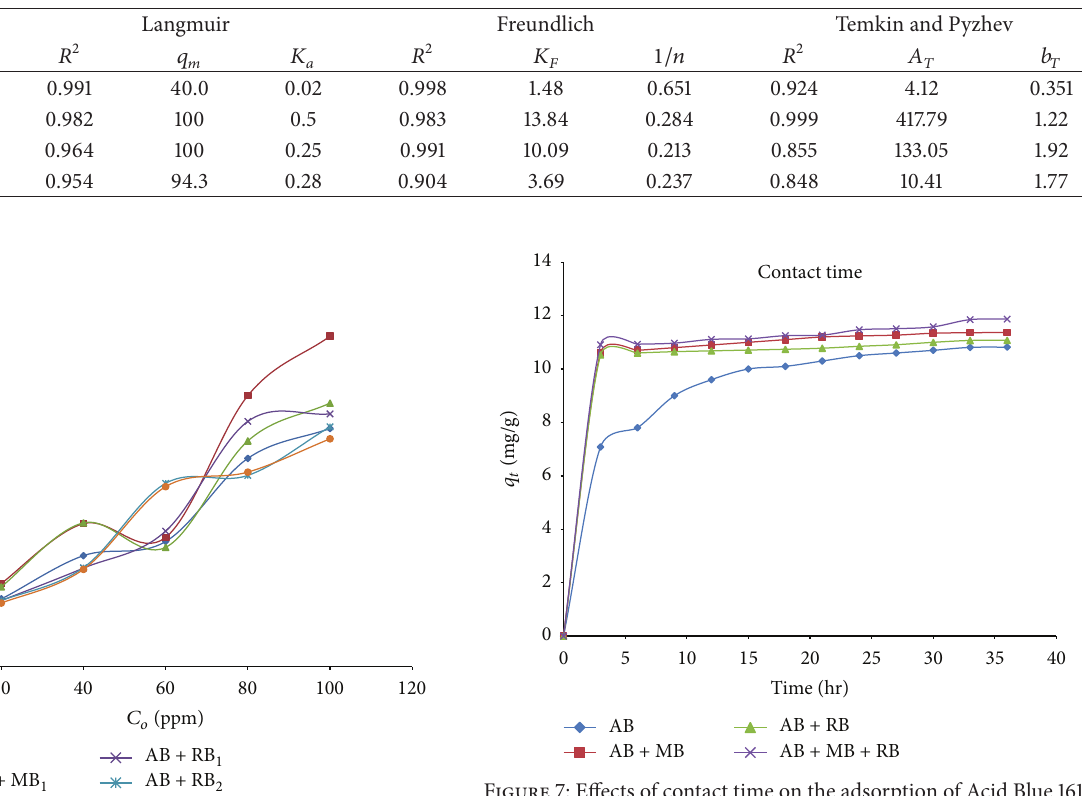
Table 2: Isotherm parameters for the adsorption of Acid Blue 161 onto raw sawdust.